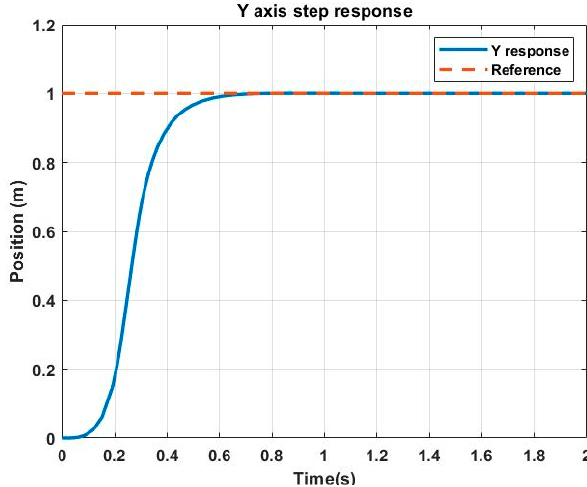
Figure 6. System response in 𝑌 axis.